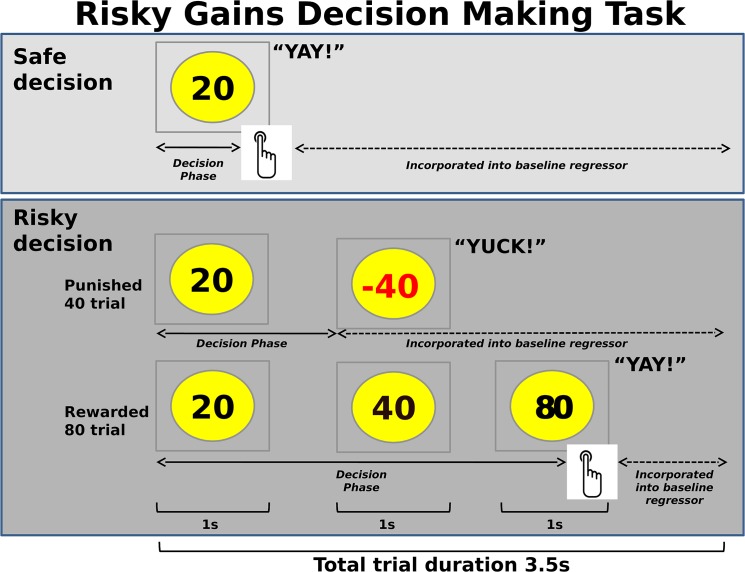
Risky Gains Task.In two subsequent gambles on 96 trials, subjects could gamble the safe option (cash in 20 cents) for double or nothing, to gain 40 or, in the potential second gamble, 80 cents (“risky” decisions). Positive values needed to be collected within their respective 1sec presentation window. 54 trials were predefined as rewarded (+20, +40, +80), 24 as punished 40 trials (-40) and 18 as punished 80 (-80) trials. Overall totals were displayed on top after a given trial, so that subjects could monitor their performance and monetary wins and losses. Decision phase regressors for fMRI analysis were defined as lasting from the onset of the trial until the subject had made a response, or, in the case of a response latency greater than 1sec, until the subject was presented with a negative value. The baseline regressor encompassed the time to initiation of the trial and the time after presenting the outcome, and also included the null trials that are interspersed.